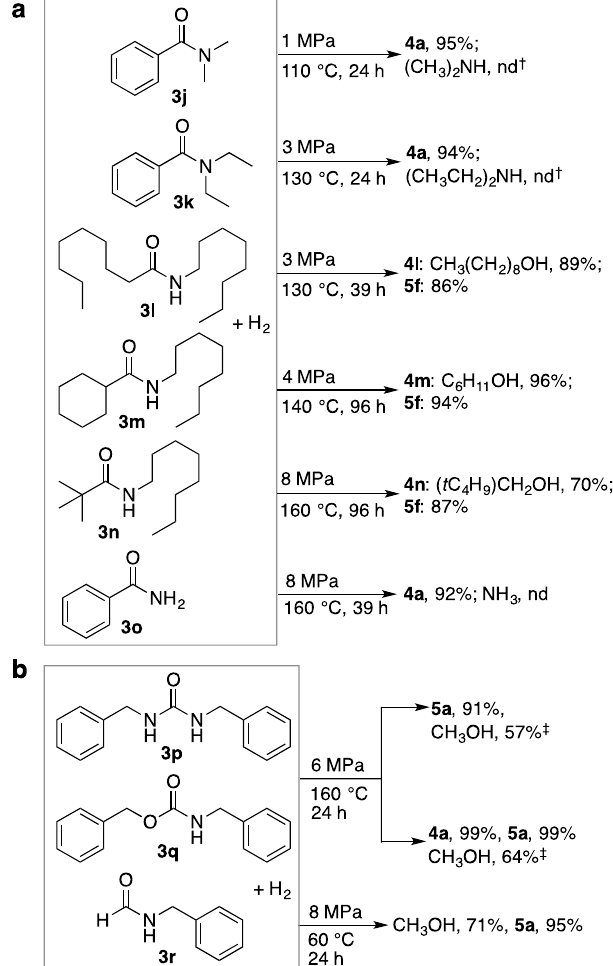
Figure 4. Hydrogenation of various unactivated amides. Unless otherwise specified, the reaction was performed using 1a (1 mol %), 3 (100 mol%), and NaH (6–10 mol %) in toluene. Pressure indicated is of H 2 at 25 °C. nd: not determined. See Supplementary Information for experimental details. ( a ) Comparison of effects of steric bulkiness of 3 on reaction conditions. † 1a was preactivated: P H2(pre) = 1 MPa, T pre = 160 °C, t pre = 5 h. ( b ) Hydrogenation of CO 2 -derived 3 . ‡ 1 mol % 1b preactivated was used instead of 1a : P H2(pre) = 8 MPa, T pre = 160 °C, t pre = 2